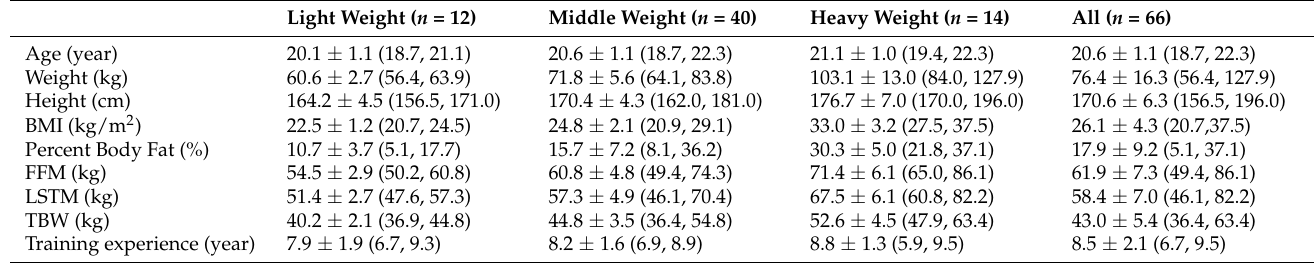
Table 1. Subjects’ characteristics of elite wrestlers in the three weight classes.